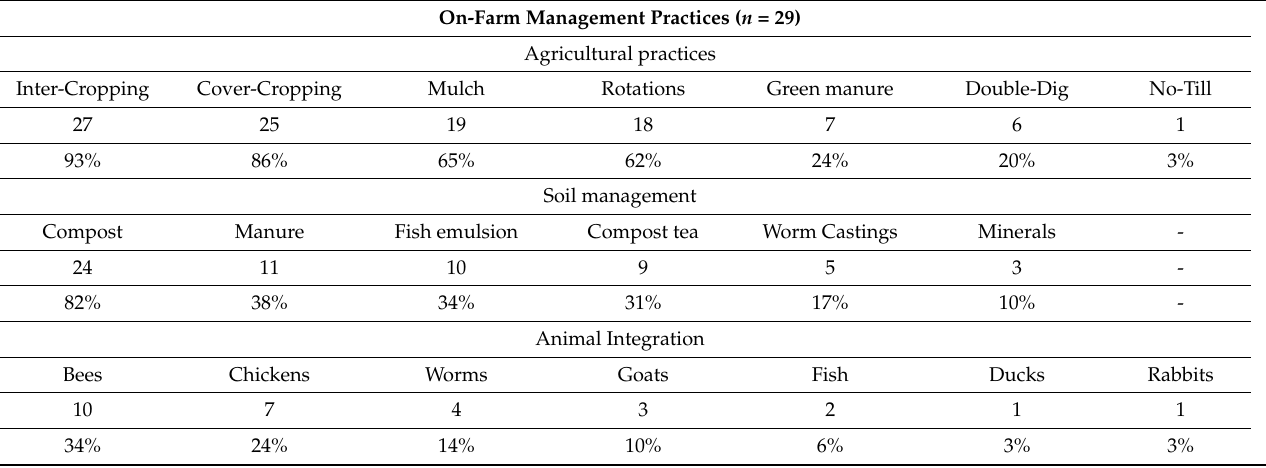
Table 2. On-farm management